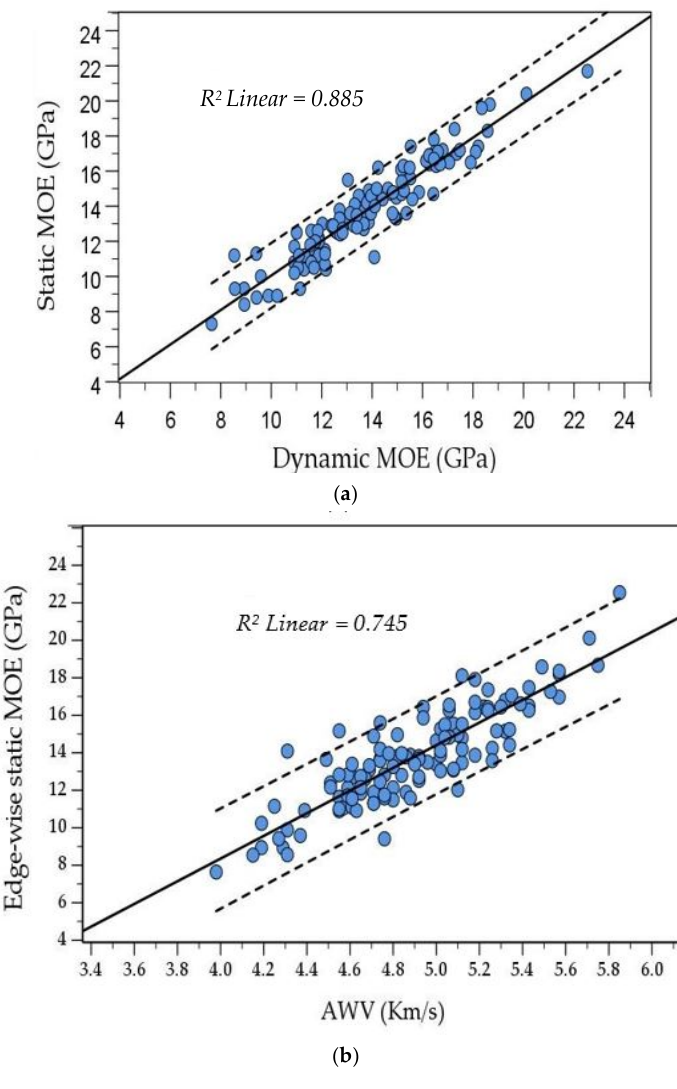
Figure 10. Correlation between static MOE and dynamic MOE predicted through AWV ( a ) and Correlation between static MOE and AWV ( b ). Table 1. Pearson correlation between the test variables of E. nitens sawn boards .